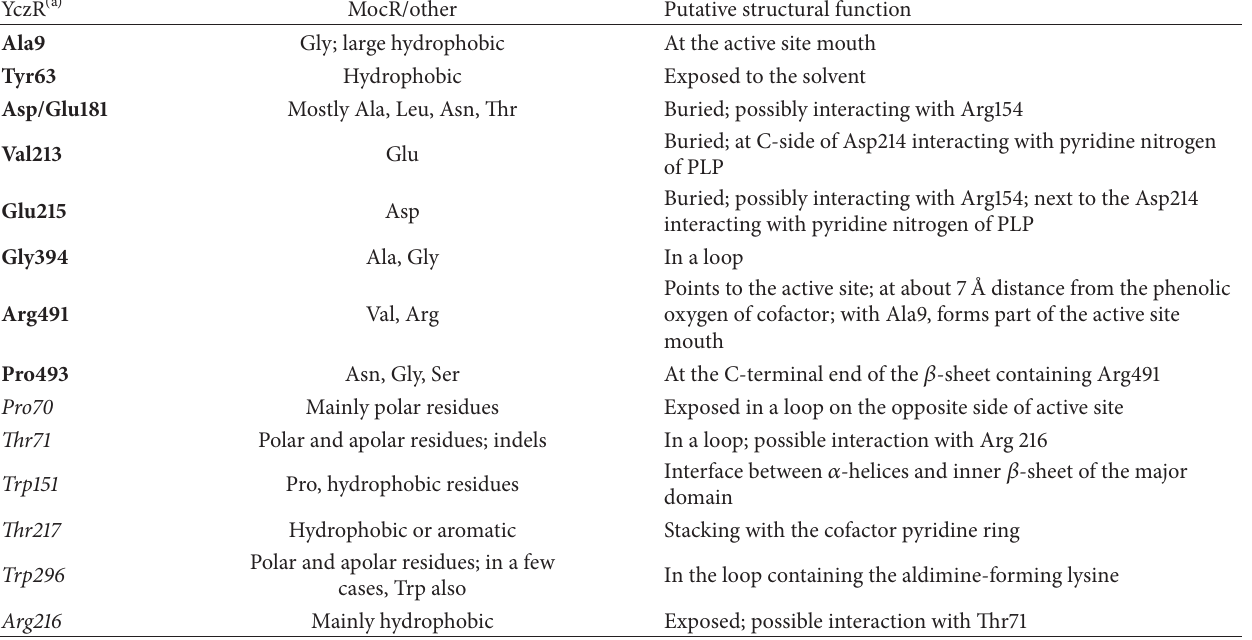
Table 3: SDPs found in the AAT domain of YczR and comparison with the residues occurring in the MocR/other. Putative functions are attributed to homology modelling.